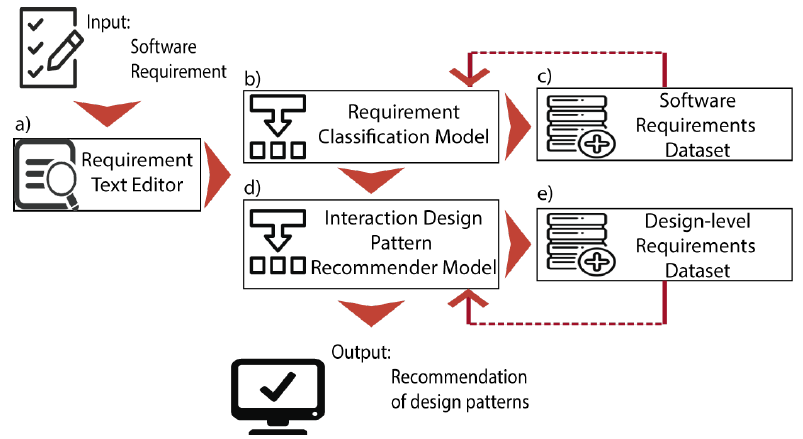
Figure 1. IDPatternM: Interaction pattern recommendation model based on